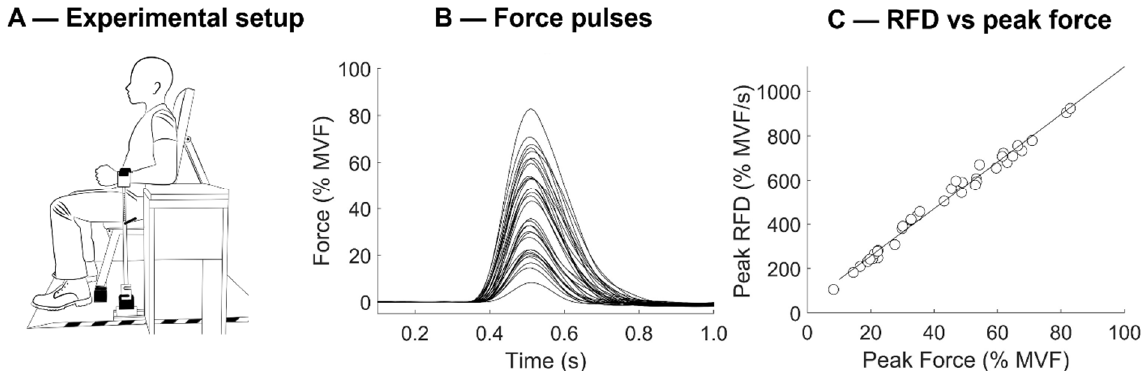
Figure 1. ( A ) The experimental setup adopted to test the elbow flexors and extensors. The arm was maintained in a neutral position. The load cell, which was rigidly attached to the